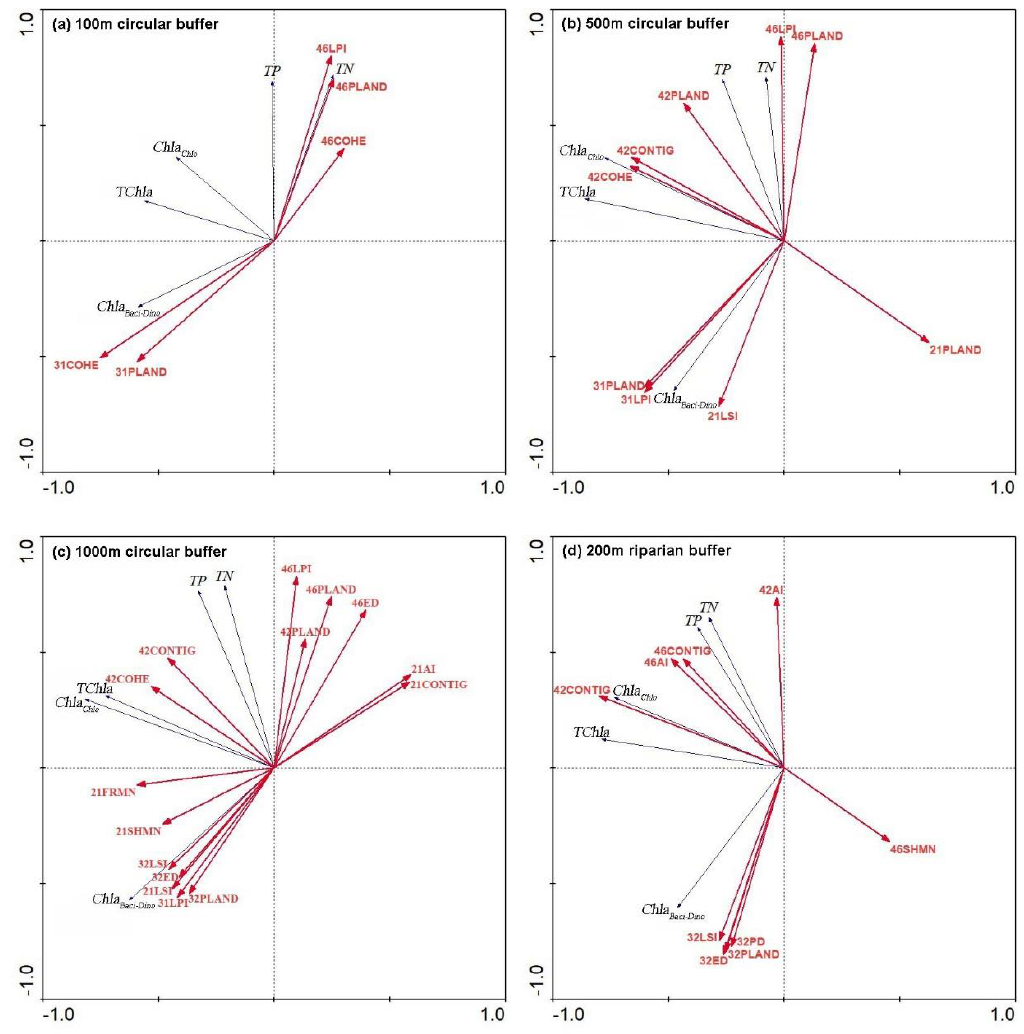
Figure 10. Biplots of water quality parameters (represented by dark blue lines) and landscape metrics (represented by red lines) within the circular bu ff ers of 100 m ( a ), 500 m ( b ) and 1000 m ( c ) and the riparian bu ff er of 200m ( d ) according to the redundancy analysis (RDA). The length of the arrow represents the standard deviation of variables in the sorting space, and the direction indicates the change of gradient direction. The cosine values of the arrow and axis represent the correlation.